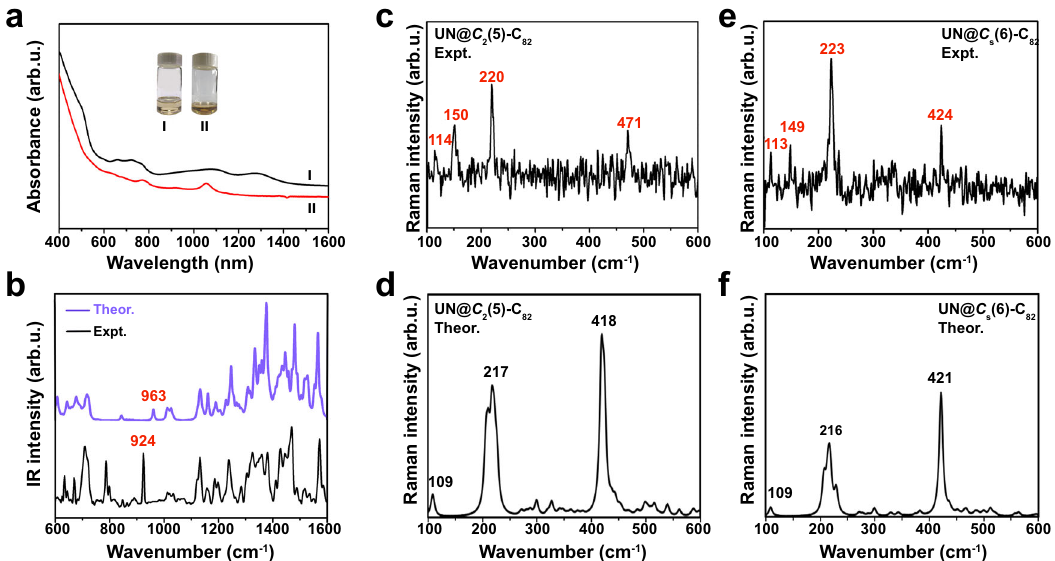
Fig. 4 | Spectroscopic characterization of UN@ C s (6)-C 82 and UN@ C 2 (5)-C 82 . a UV − vis − NIR spectra of UN@ C s (6)-C 82 (I) and UN@ C 2 (5)-C 82 (II). b FTIR spectra of UN@ C 2 (5)-C 82 . c , d Experimental Raman spectra of UN@ C 2 (5)-C 82 and theoretical